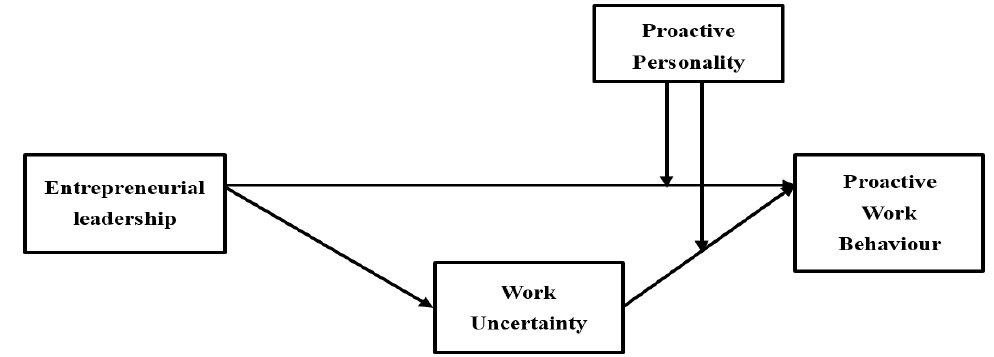
Figure 1. Research